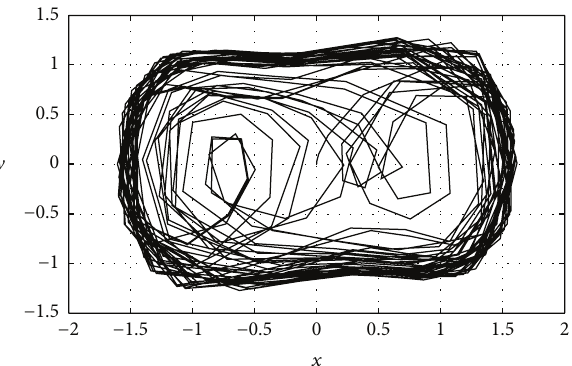
Figure 1: 2D Duffing chaotic system phase diagram.